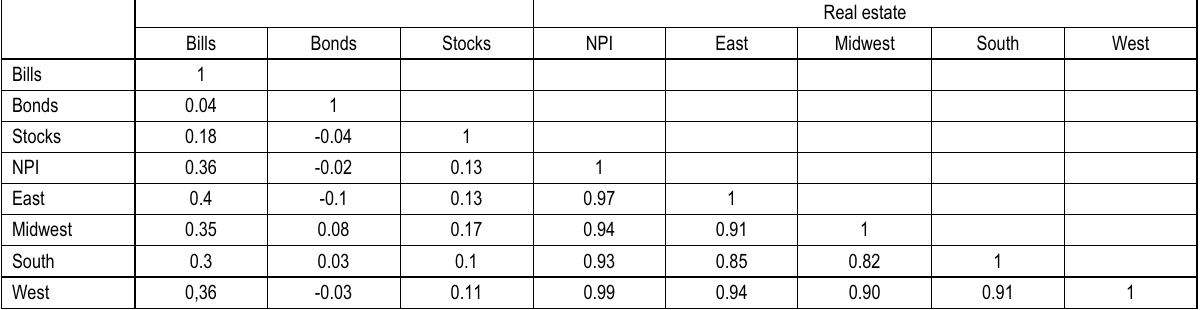
Table 2. Correlation coefficients – bonds, stocks and real estate, 1978-2012 This Table shows correlations of quarterly returns for bills, bonds, stocks and real estate over the period 1978-2012. Stocks are negatively correlated with both bonds (correlation of -0.04), but positively with real estate (correlation of +0.13 with NPI). Real estate is negatively correlated with bonds (a correlation of